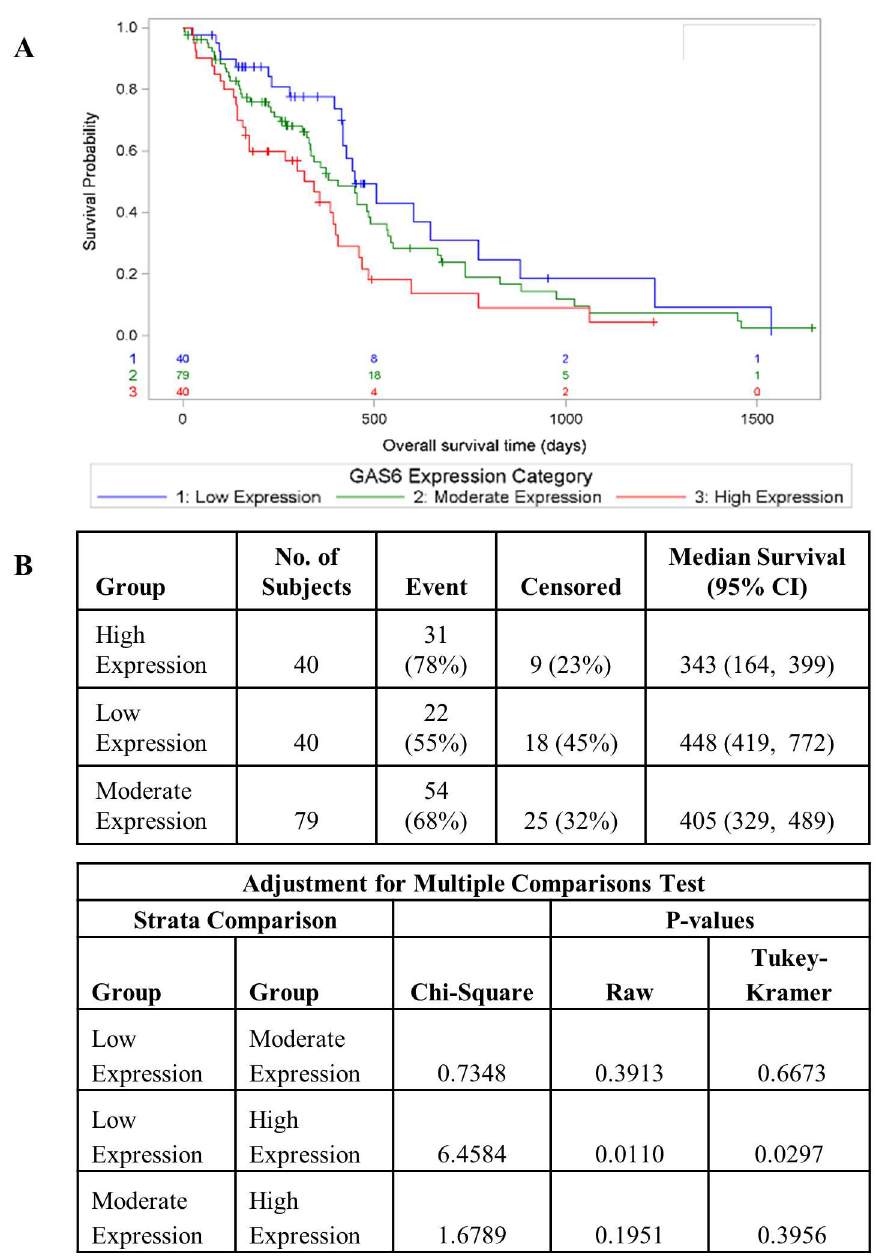
Fig 1. High levels of GAS6 expression correlate with poor prognosis in GBM. GBM samples from the TCGA data base were divided into quartiles based on GAS6 transcript levels and samples with low (bottom quartile), moderate (middle quartiles) and high (top quartile) GAS6 expression were defined. A) Kaplan- Meier curves showingoverall survival of GBM patients as a function of GAS6 expression. B) Statistically significant differences were determined using the log rank test and Tukey’s studentizedrange test was used to adjust for multiple comparisons. Hazard ratios were calculated using Cox proportional-hazards model and the low expressioncategory as the